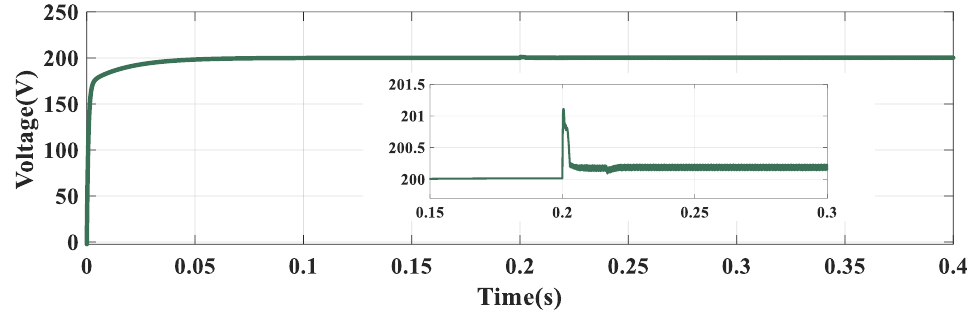
Figure 12. Study 2: load